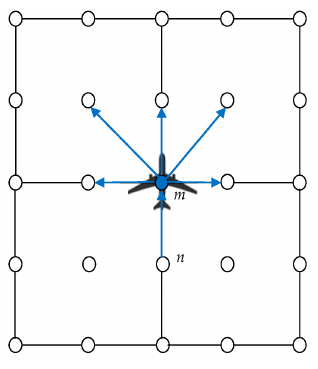
Figure 5. Schematic diagram of turning radius